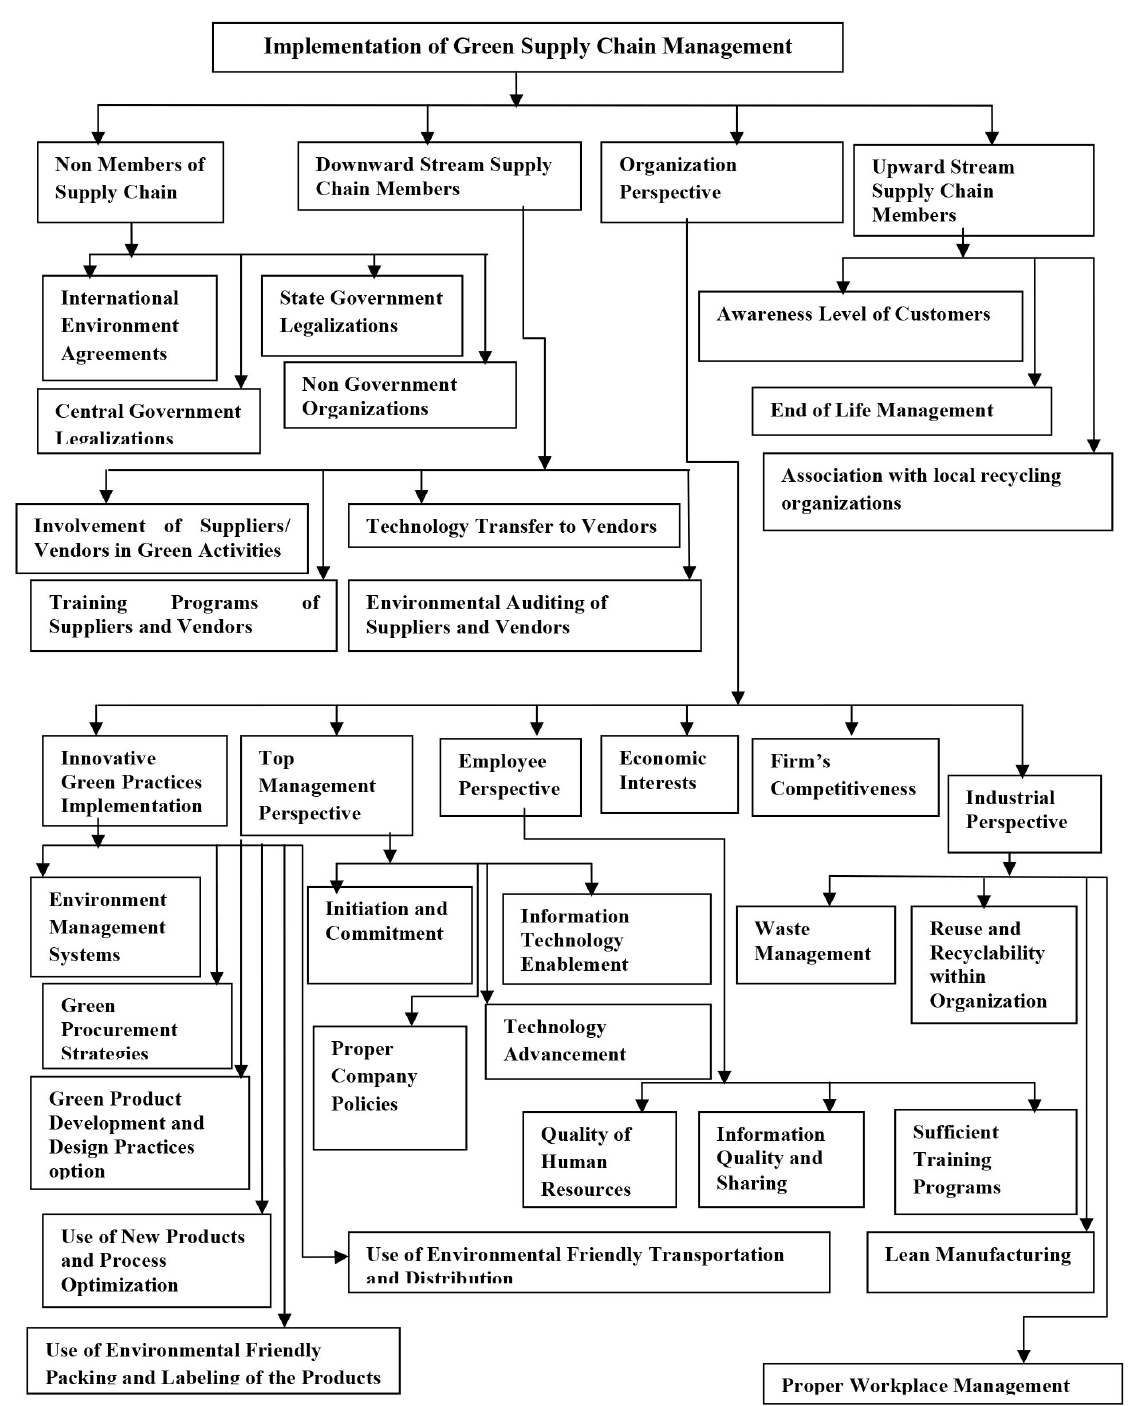
Figure 1. Research frame work of strategies to implement GSCM in Indian manufacturing